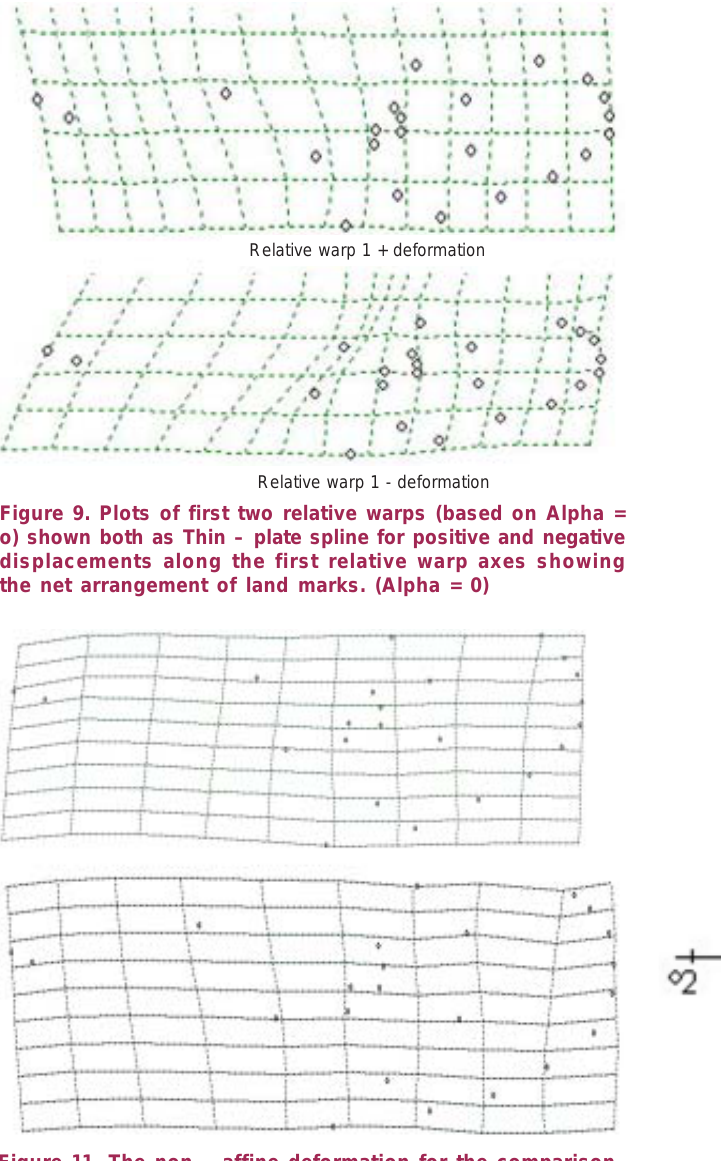
Figure 10. Ordination by the non-affine shape 1st , 2nd and 3rd components for Culex quinquefasciatus male and females (Alpha = 0).